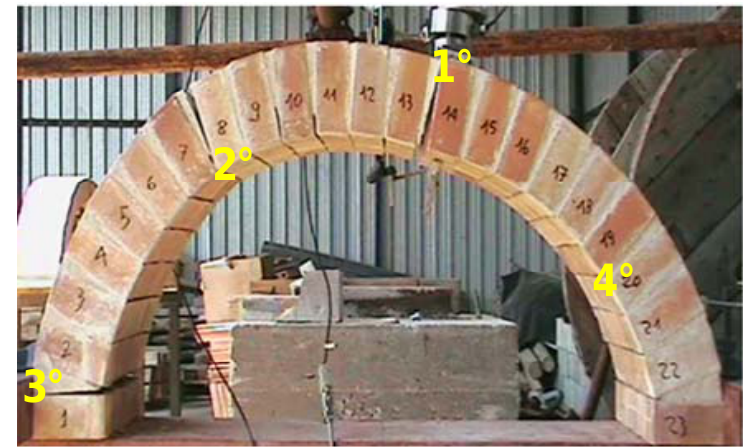
Figura 10: Arco sperimentale: numerazione dei mattoni e cinematismo di collasso.